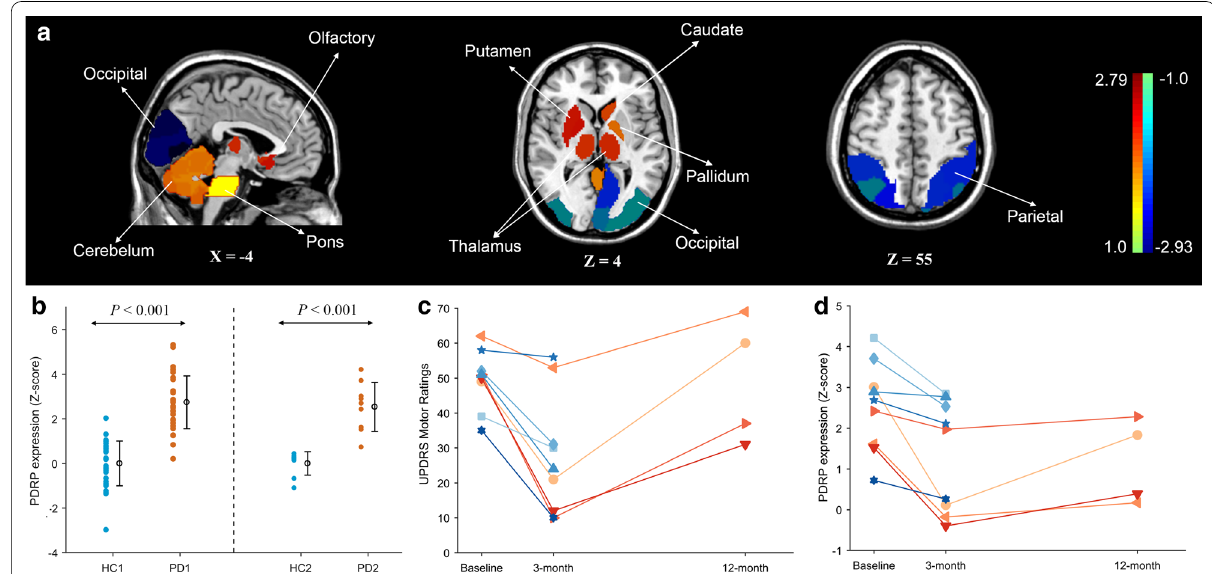
Fig. 1 a PDRP identified by pattern analysis in 18 F-FDG PET images from PD1 patients and HC1 subjects. This pattern was characterized by relatively higher metabolism in the bilateral putamen, pallidum, caudate, thalamus, cerebellum, pons and olfactory region, which was associated with decreased metabolism in the posterior parietal–occipital cortices. Regions with metabolic increases (positive region weights) are color-coded from red to yellow; those with metabolic decreases (negative region weights) are color-coded from blue to purple. b The expression of the PDRP pattern showed that the subject scores of PD patients were relatively higher than those of HC subjects in both cohort I and cohort II ( P < 0.001). UPDRS motor ratings ( c ) and PDRP scores ( d ) in PD2 patients at preoperative baseline, 3-month post-operation and 12-month post-operation in STN DBS “OFF” states both exhibited significant changes across intervals ( P < 0.01; RMANOVA). The scatters of different colors and shapes represent the PD patients with DBS